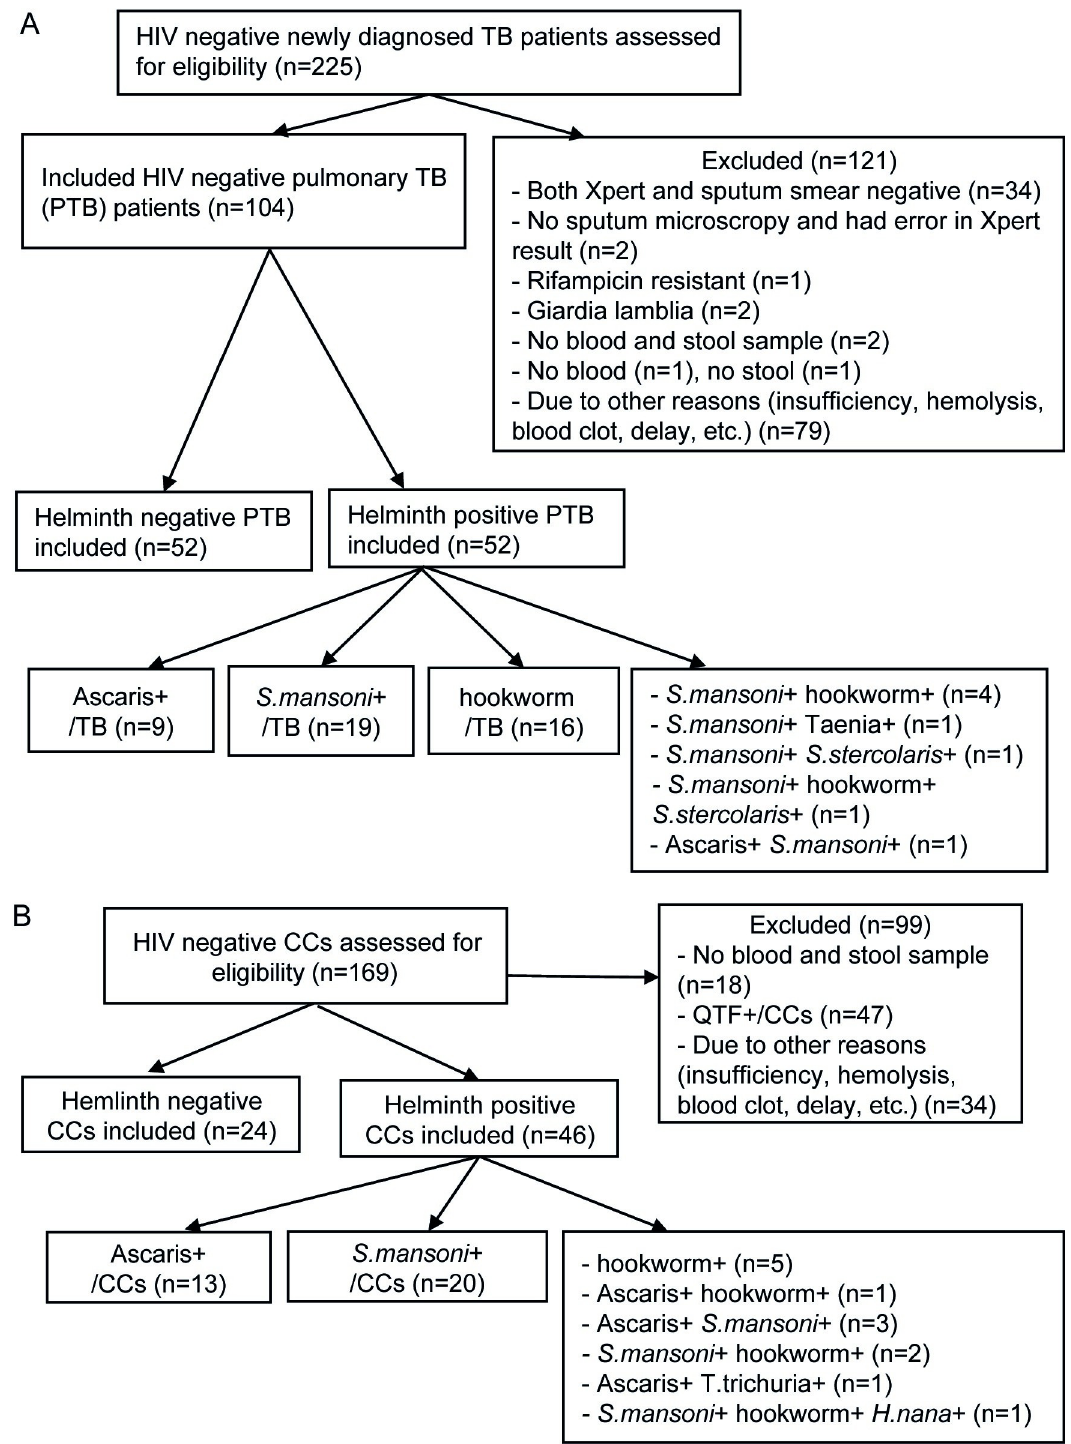
Fig 1. Flowchart of the inclusion process. (A) For pulmonary tuberculosis patients the study was conducted at four Directly Observed Treatment Short-Course Clinics of the University of Gondar Specialized Hospital, Gondar Health Center, Maraki and Azezo Health Centers, Ethiopia. (B) For healthy community controls.